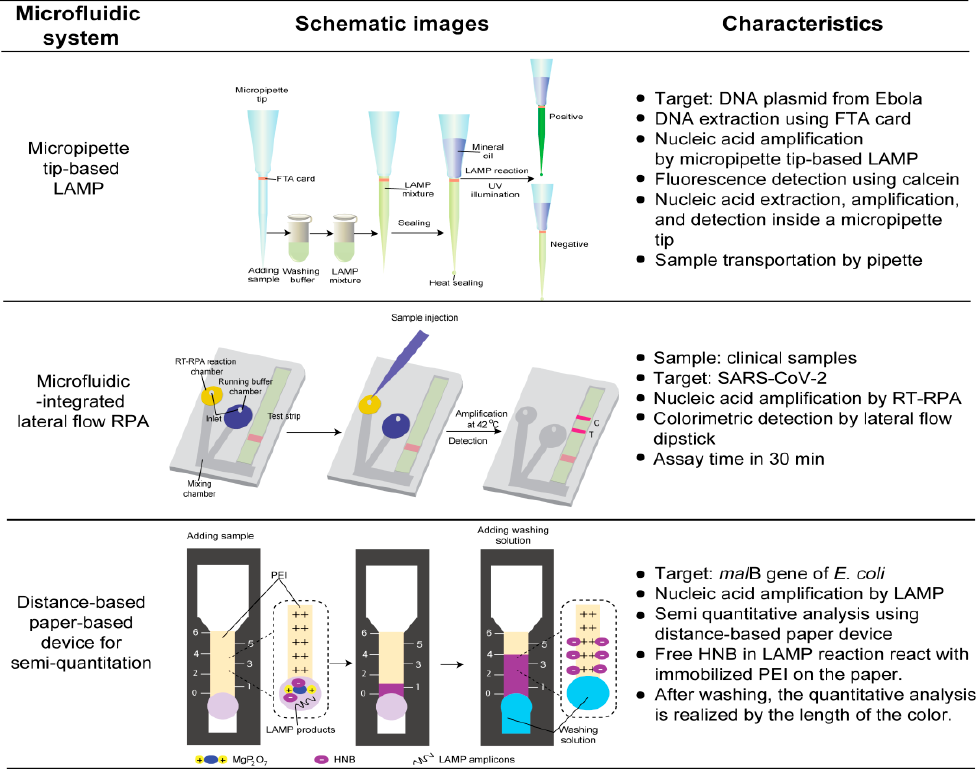
Figure 4. Examples of microfluidic devices used for isothermal nucleic acid amplification for pathogen detection. Reproduced from [58,62,65].